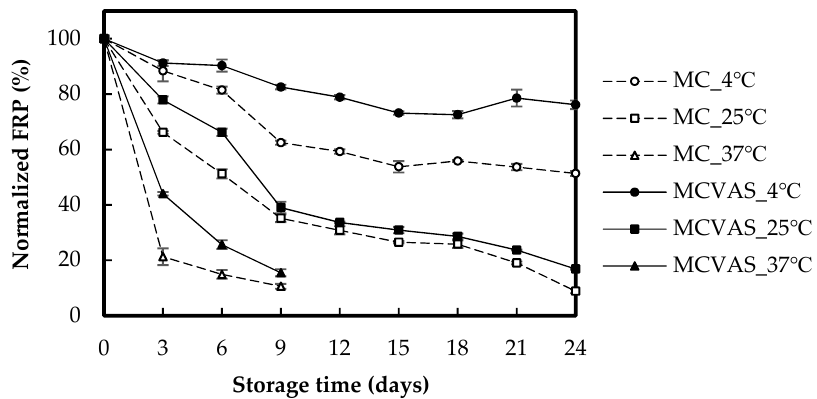
Figure 6. Effects of storage time on the normalized ferric reducing power of Momordica charantia L. and Momordica charantia L. var. abbreviata Ser.